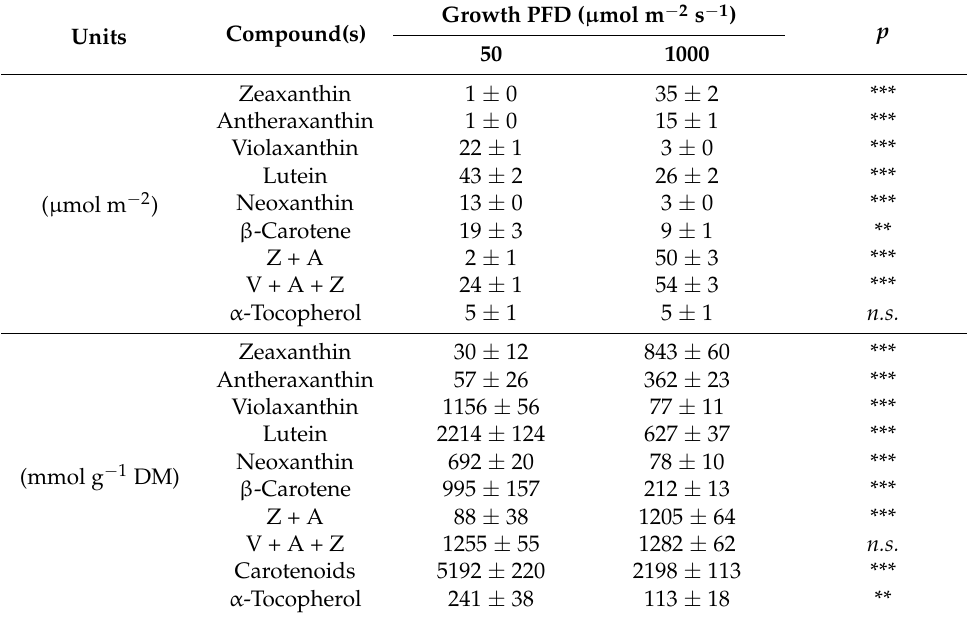
Table 1. Levels of carotenoids and α -tocopherol per frond area and dry mass (DM) in fronds of